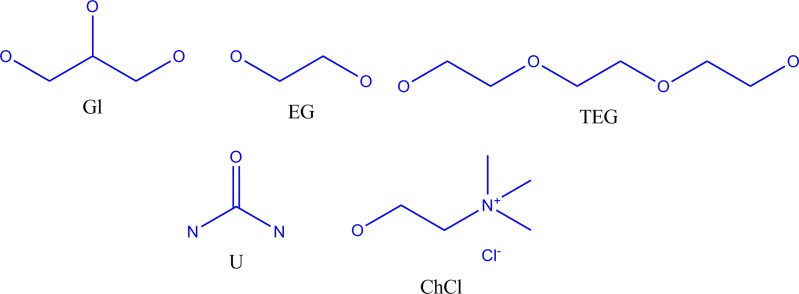
Structures of the salt and HBDs.